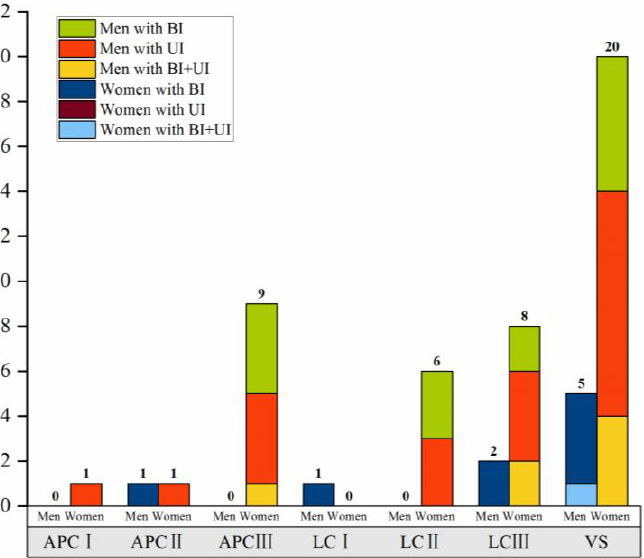
Figure 3. Distribution of LUTIs according to the Young–Burgess classification. BI, bladder injury; UI, urethra injury; APC, anteroposterior compression; LC, lateral compression; VS, vertical shear.